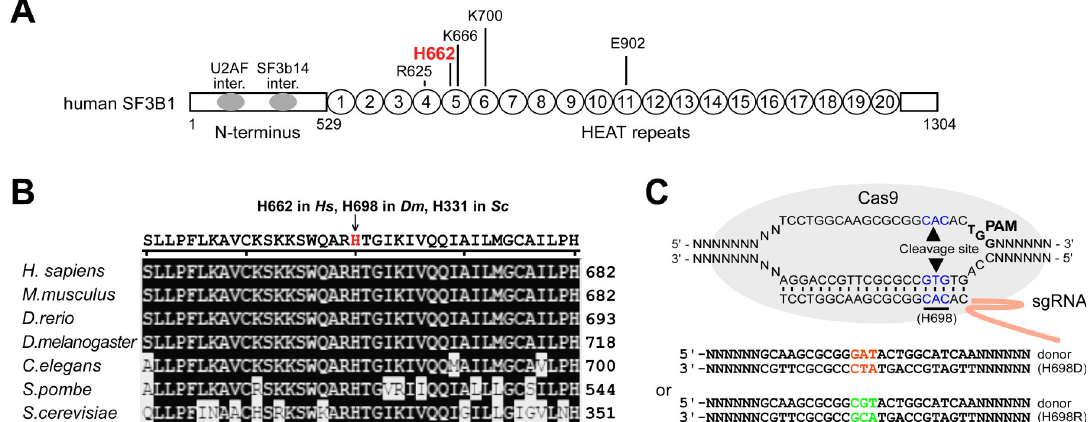
Fig 1. Construction of sf3b1-H698D and -H698R mutant strains. ( A ) Frequent mutations of SF3B1 in human cancers. The most frequently mutated five sites, motifs and domains of human SF3B1 are indicated. ( B ) Alignment of SF3B1 homologous proteins from the yeast to human. The conserved histidine residue, amino acid position 662 in humans and 698 in Drosophila , is indicated. ( C ) Schematics for the construction of sf3b1-H698D and -H698R mutant strains using a CRISPR/cas9 system. Mutated sequences for coding are in orange and green, and the WT histidine sequence is in